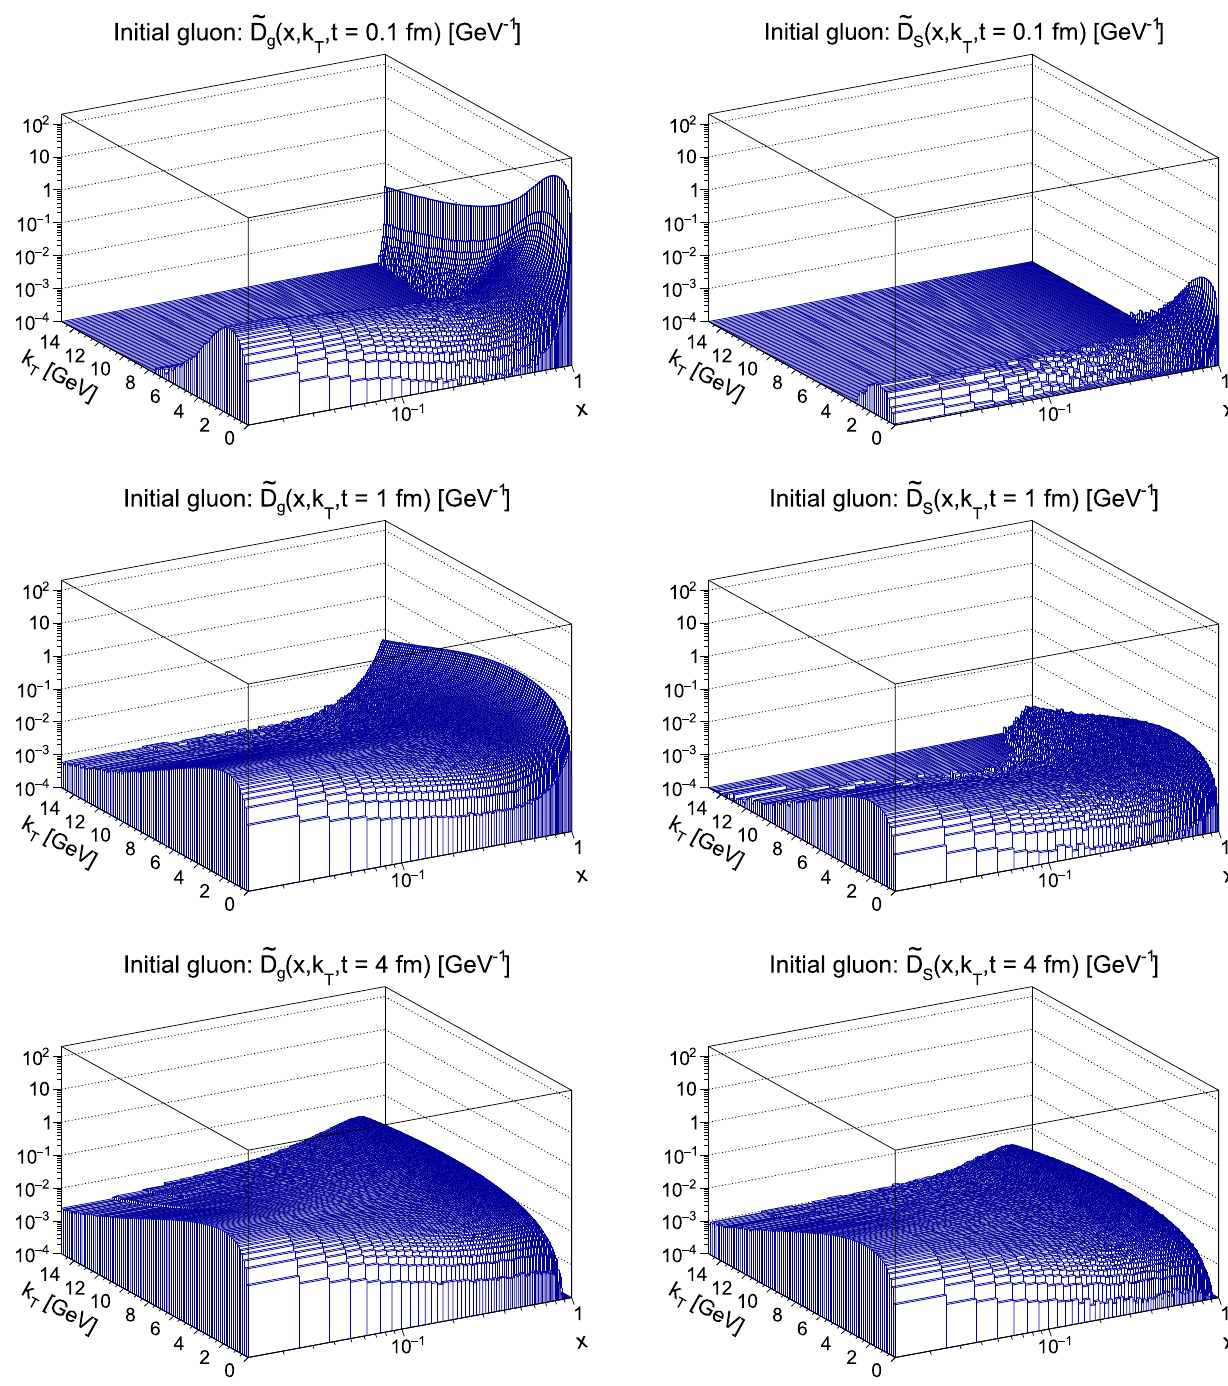
+ l 2 ) ] at the time-scales D